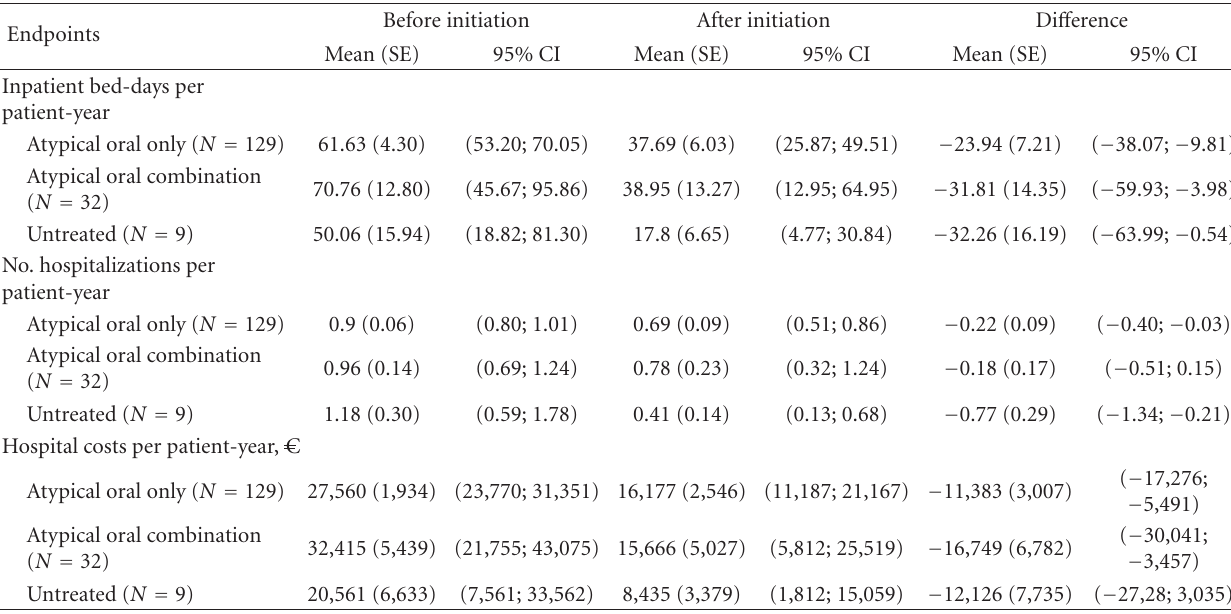
Table 7: Results of the subgroup analysis for the endpoints: inpatient bed-days per patient and year, number of hospitalisations per patient and year, and hospital costs per patient and year. Results are presented for previous therapy subgroups containing more than 5